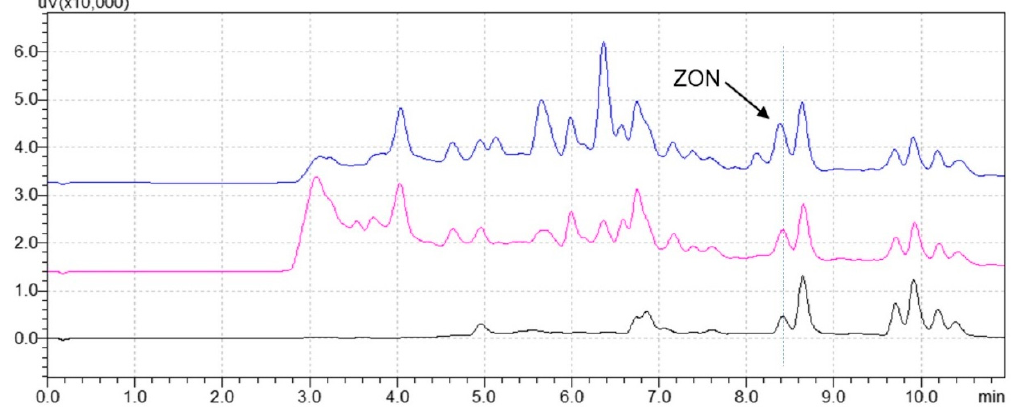
Figure 5. Chromatograms of crude maize oil spiked with 200 µ g / kg of ZON after extract clean-up with QuEChERS (blue trace), LLE (pink trace), and MIP-SPE (black trace).